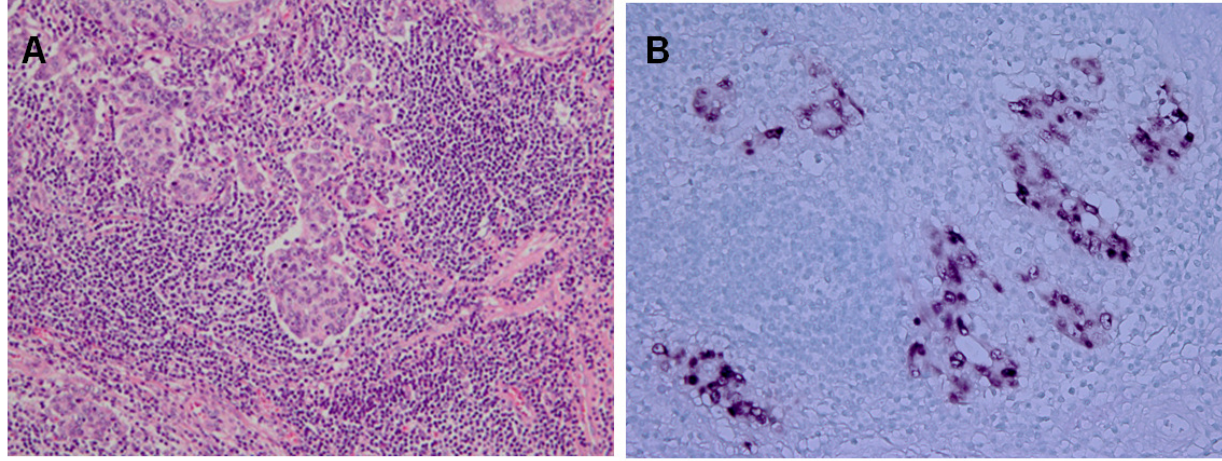
Figure 1. Lymphoepithelioma-like subtype of Epstein-Barr virus-associated gastric carcinomas (EBVaGC).A . Hematoxylin-Eosin Staining. B. EBV-encoded small ribonucleic acid- in situ hybridization (EBER1-ISH) demonstrates positive nuclei in the carcinoma cells, which are surrounded by infiltrating